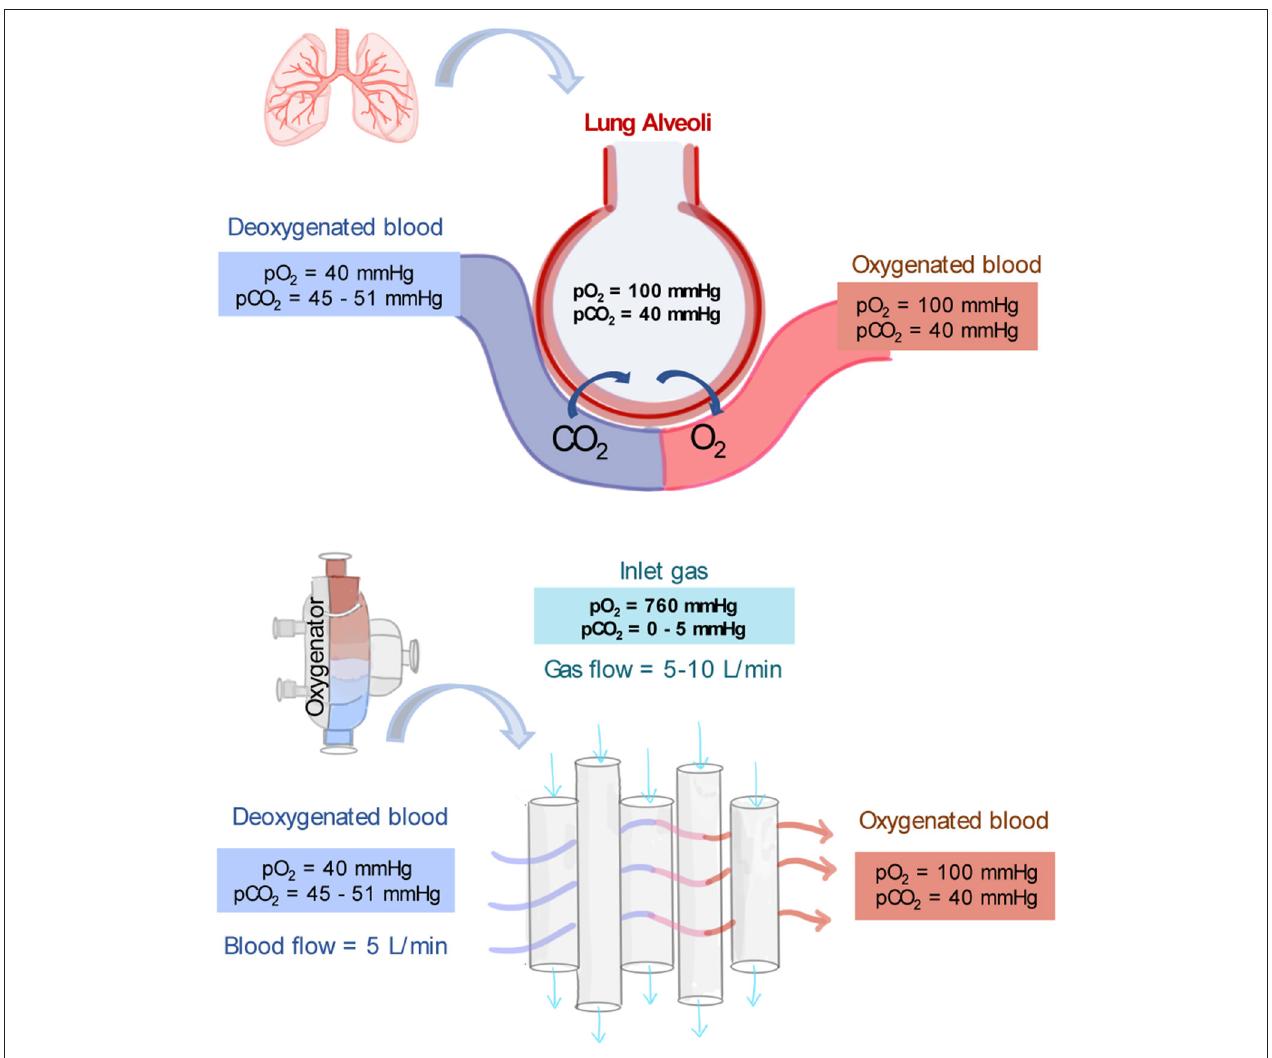
FIGURE 3 | Typical partial pressures of oxygen (pO 2 ) and carbon dioxide (pCO 2 ) in the lung’s alveoli, in deoxygenated blood and oxygenated blood. In addition, typical operating conditions and partial pressure of gases as driving force for gas exchange in the core of oxygenators (55,